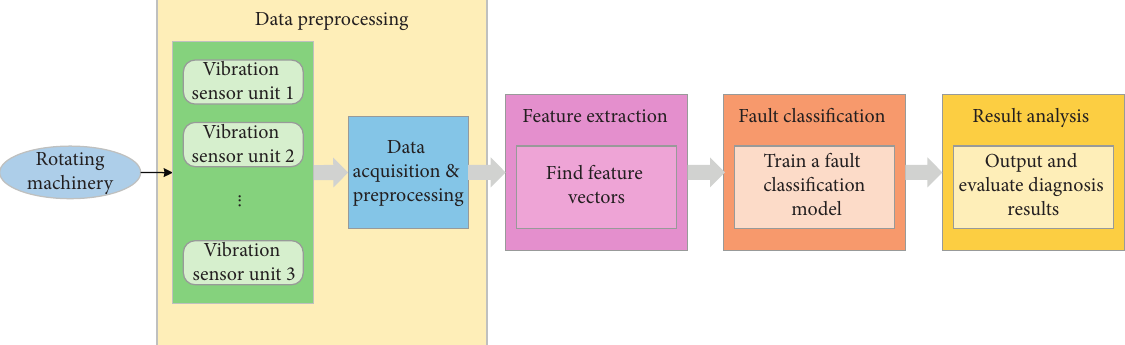
Figure 1: Functional framework of the automatic fault diagnosis